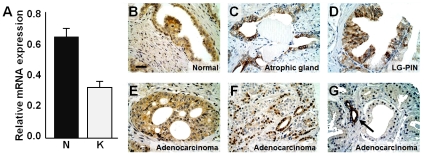
Mitostatin is down-regulated in human prostate cancers.
A: Relative fold of Mitostatin mRNA levels in normal prostatic tissue samples (N, black), and Gleason 7 prostate cancer samples (K, bright gray). Mitostatin showed a consistent down-regulation in cancer tissues (P = 0.029). Columns, representative images of triplicates; bars, SD. B–G: Immunohistochemical detection of Mitostatin in human prostate. Mitostatin protein is localized in the cytoplasm of normal (B) and atrophic (C) prostatic glands. Higher levels of Mitostatin protein were observed in PIN lesions (D) and in some tumors (E). F: In addition to a weak staining, Mitostatin was also detected in the nuclei in few cases of adenocarcinoma. G: Mitostatin expression is present in an atrophic gland (black arrow) in contrast with the surrounding negative neoplastic glands. Scale bar: 50 µm.